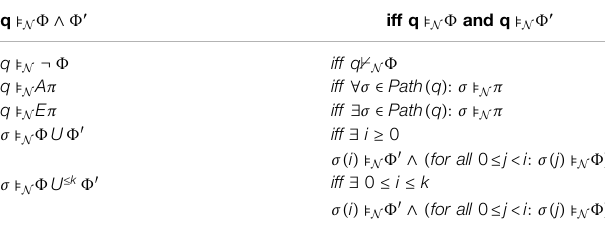
TABLE 2 | Satis fi ability relation of the network logic. q ⊧ N Φ ∧ Φ 9 iff q ⊧ N Φ and q ⊧ N Φ